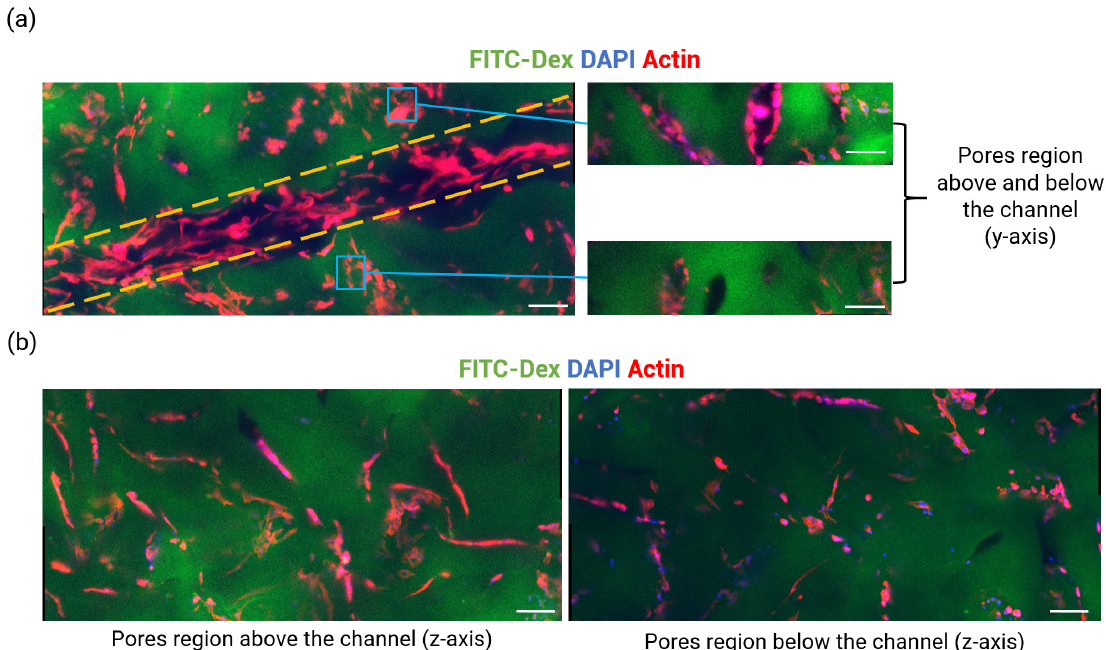
Figure 8. Cell analysis of seeded HUVECs on CoCmx scaffolds. ( a ) Images represent Z-Projection (average intensity) inside the scaffold’s channel. Scale bar = 100 μ m. Yellow dashed lines represent the limit of the microchannel; ( b ) Images represent Z-Projection (average intensity) of the same scaffold, in the porous regions outside the channel (z ‐ axis). Scale bar = 100 μ m.